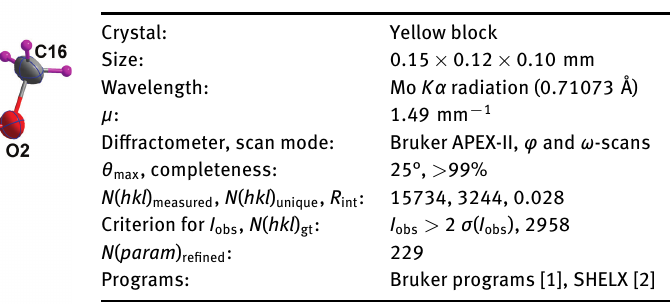
Table 1: Data collection and handling.